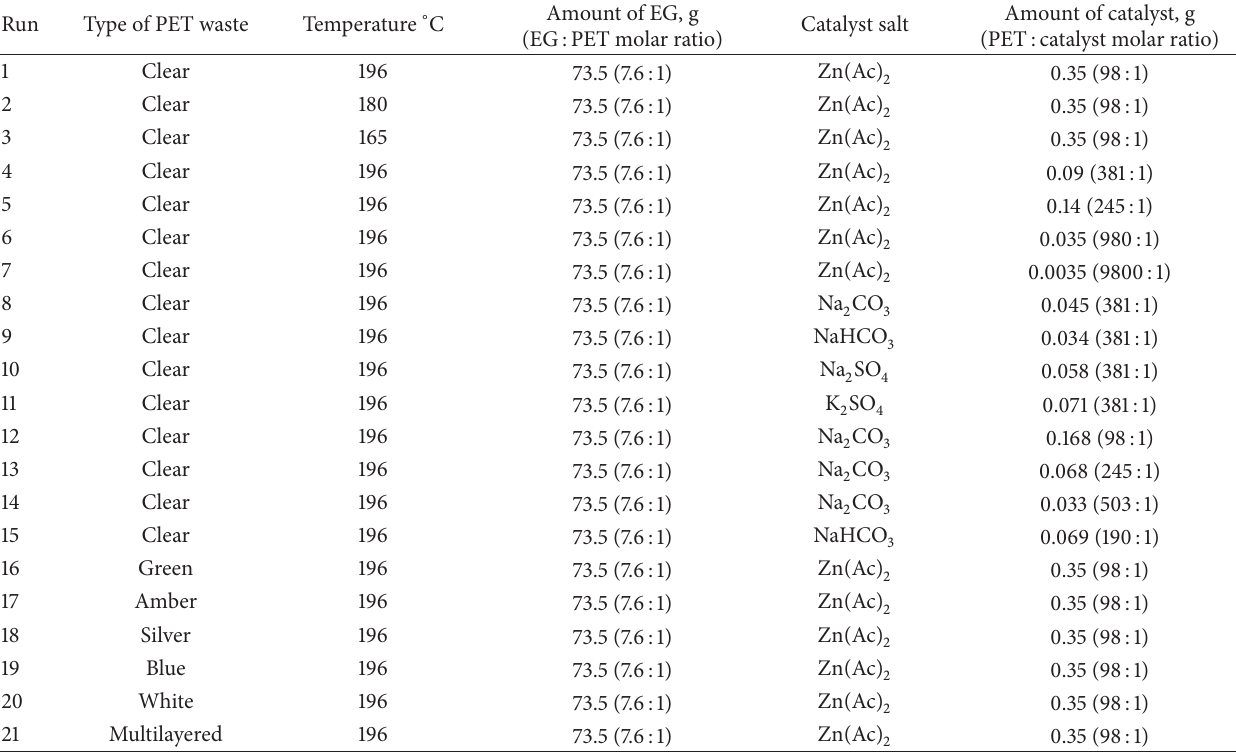
Table 3: Formulation and amount of materials used in glycolysis